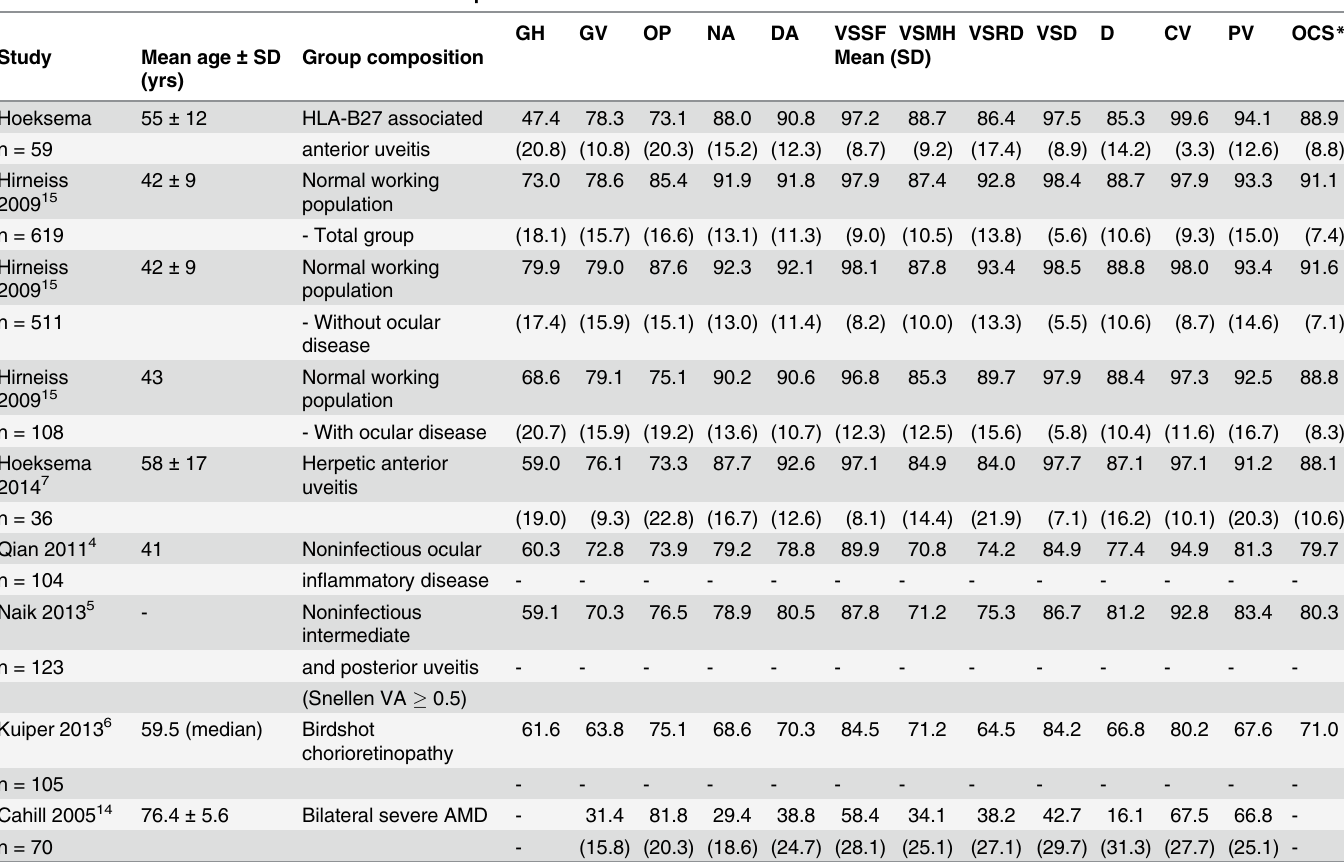
Table 5. NEI VFQ-25 subscale scores and OCS compared with literature.